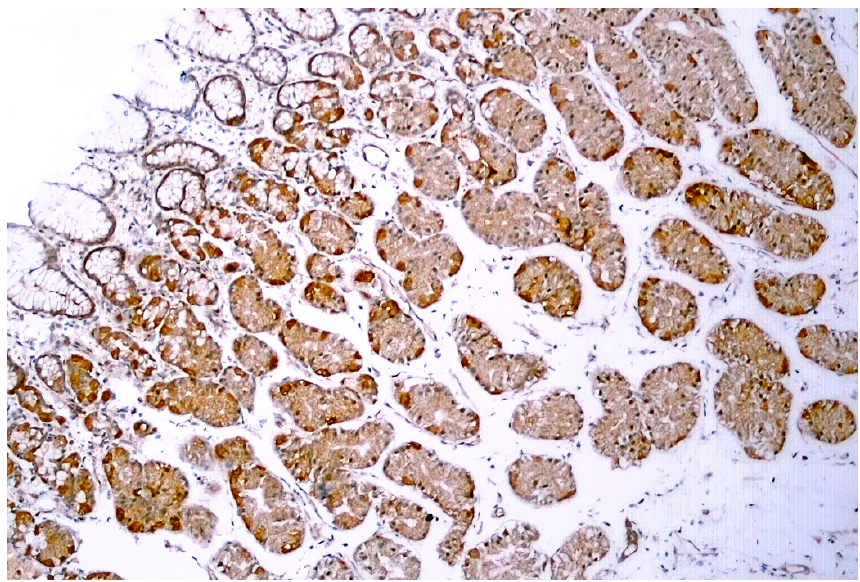
Figure 5. TRPV1-like immunoreactivity in human gastric biopsy (normal body weight individual). Figure courtesy of Dr. Gülsüm Özlem Elpek, Akdeniz University, Turkey.